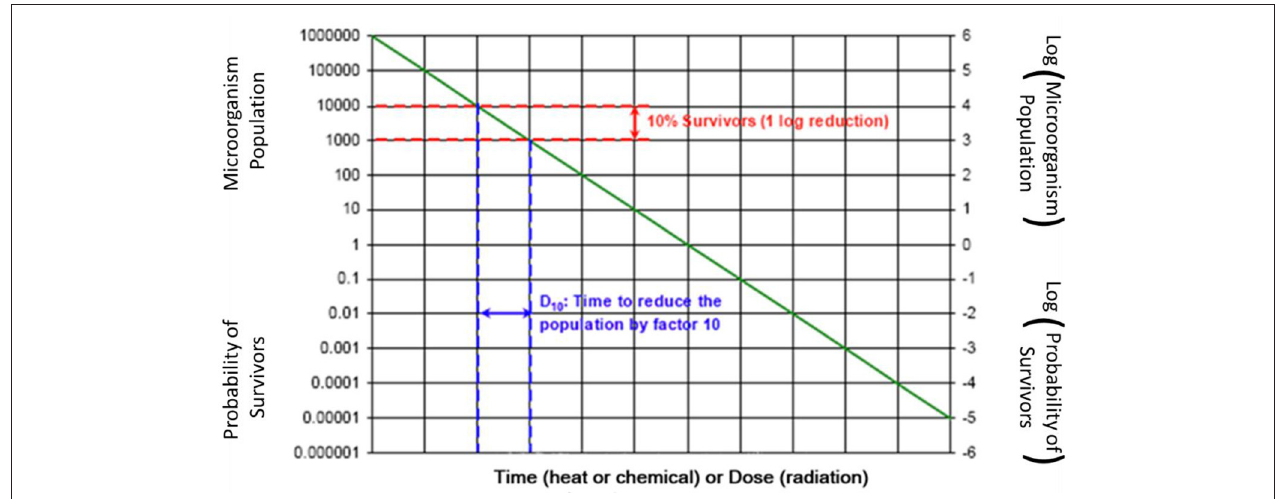
FIGURE 2 | Schematic of traditional terminal sterilization microbial log reduction [(4), Figure 1